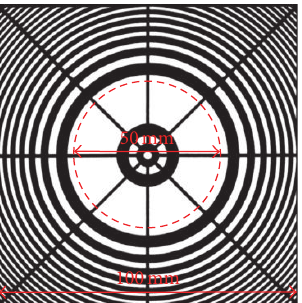
Figure 5: The phase distribution of the designed and manufactured diffractive lens structure (scanned), where white areas introduce 𝜋 phase shift and black do not change the